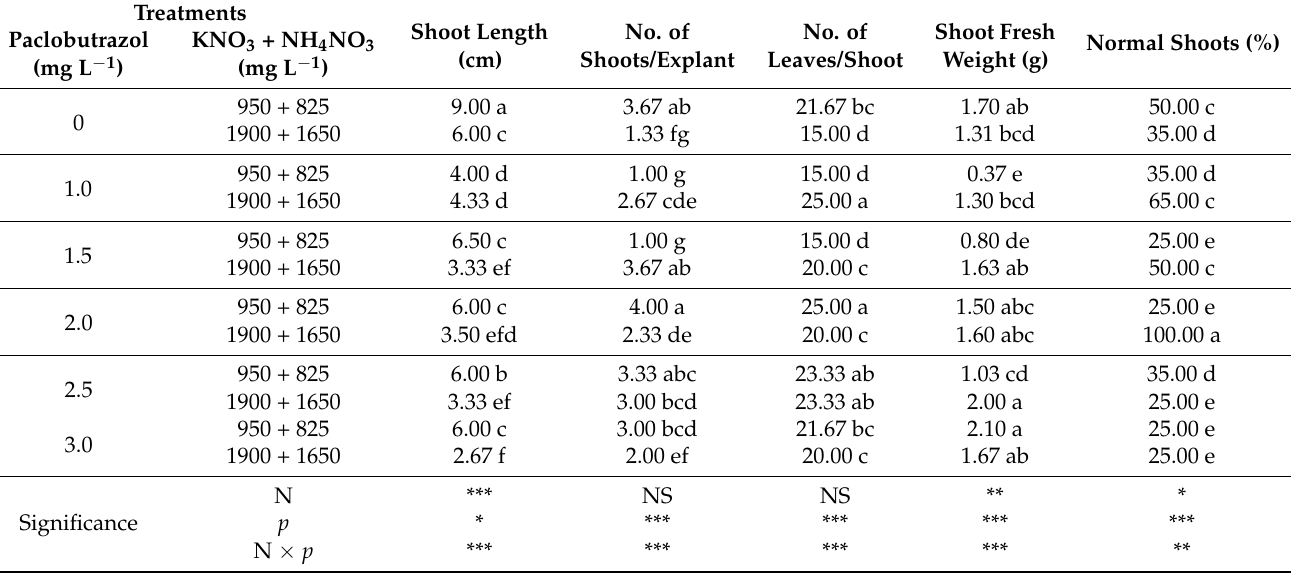
Table 4. Effect of paclobutrazol and nitrate salts on growth and hyperhydricity reversion of G. paniculata in vitro shoots after four weeks. All media were solidified with 9 g L − 1 agar. All cultures were kept at light density of 30 µ mol m − 2 s − 1